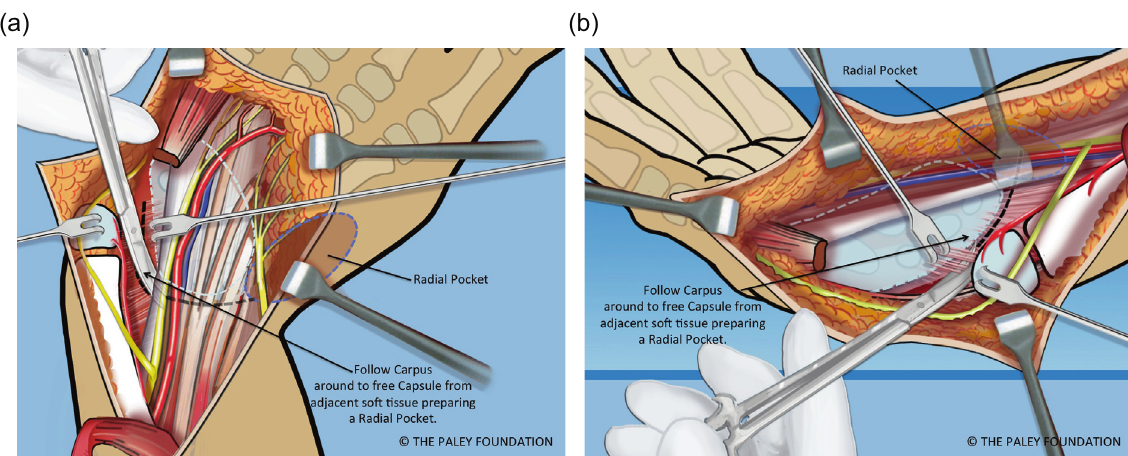
Figure 8. The capsular tissues are dissected by following around the proximal edge of the carpus towards the radial side (a,